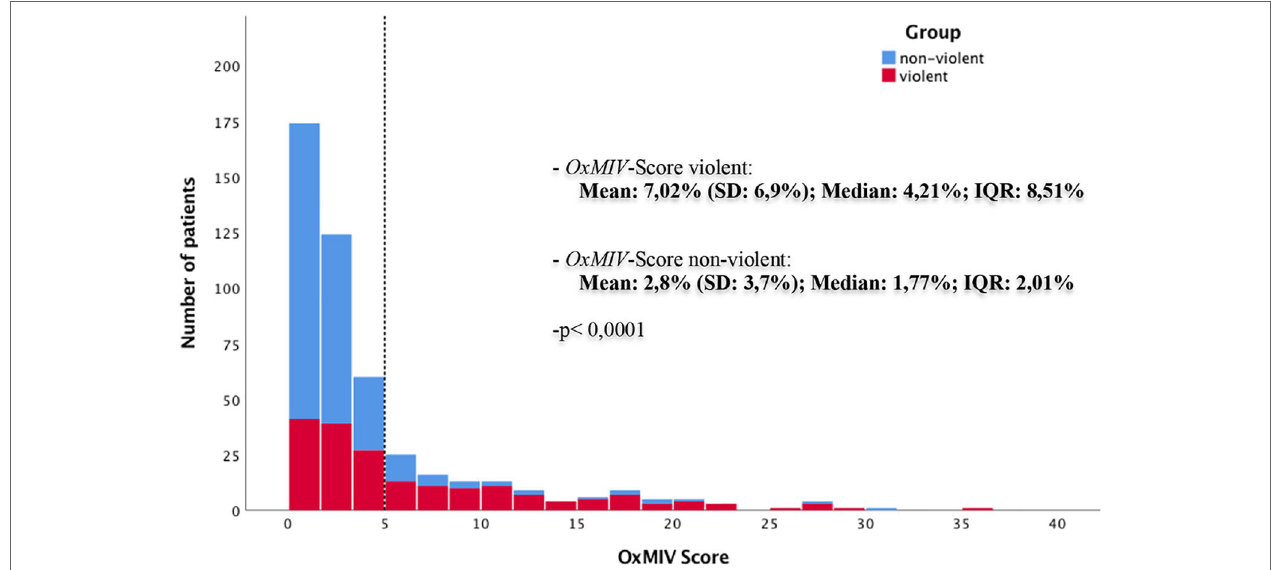
TABLE 2 | Two-by-two table using the OxMIV score and the 5% cutoff to derive sensitivity, specificity, positive prediction value, and negative prediction value to identify “increased-risk” patients for violent behavior during their stay.